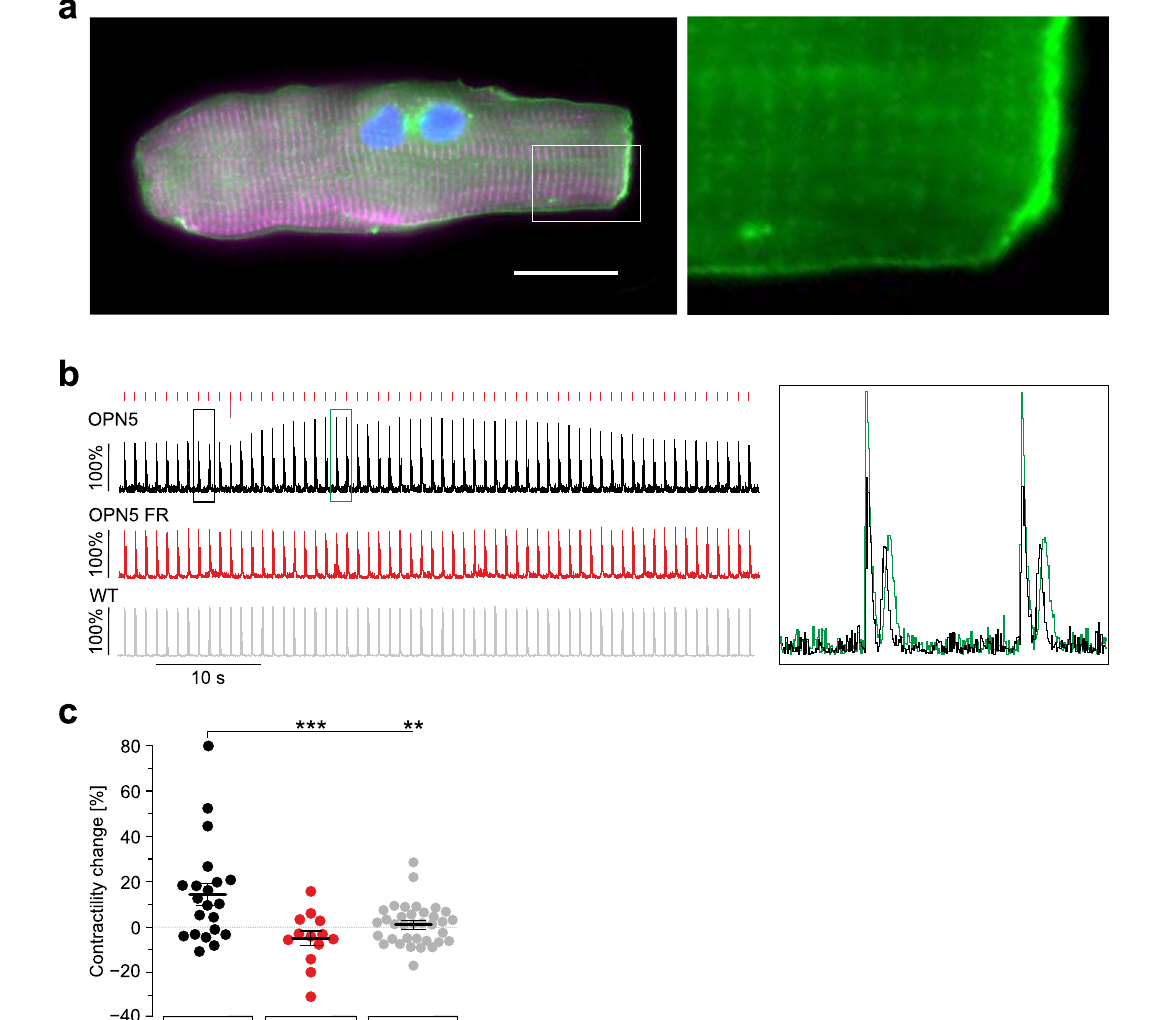
Fig. 7 hOPN5 increases contractility in adult ventricular cardiomyocytes. a Adult α -actinin (purple) positive ventricular cardiomyocyte from an hOPN5/ eYFP transgenic heart with eYFP signals (green) in the membrane and t-tubule invaginations (DAPI in blue, bar = 20 µ m). b Representative trace showing the contractility analysis (average pixel displacement per frame) of ventricular cardiomyocytes expressing hOPN5 before (black) and after application of FR900359 (1 µ M, red) as well as of a control cardiomyocyte from a CD1 wild-type mouse (gray) during electrical pacing (1 Hz, red lines) with one UV light pulse (385 nm, 1 mW/mm 2 , 100 ms, violet arrow). Insert highlights the stronger contraction after (green) compared to before (black) illumination. c Statistical analysis of contractility change (each dot represents the result from one cardiomyocyte, isolated from 4 mice for hOPN5 and 3 for CD1 wild- type control mice) was performed with a non-parametric ANOVA test with Tukey ’ s multiple comparison post-test (p(WT vs hOPN5 FR) = 0.4). Data are presented as mean values ±SEM. ** p < 0.01, *** p <